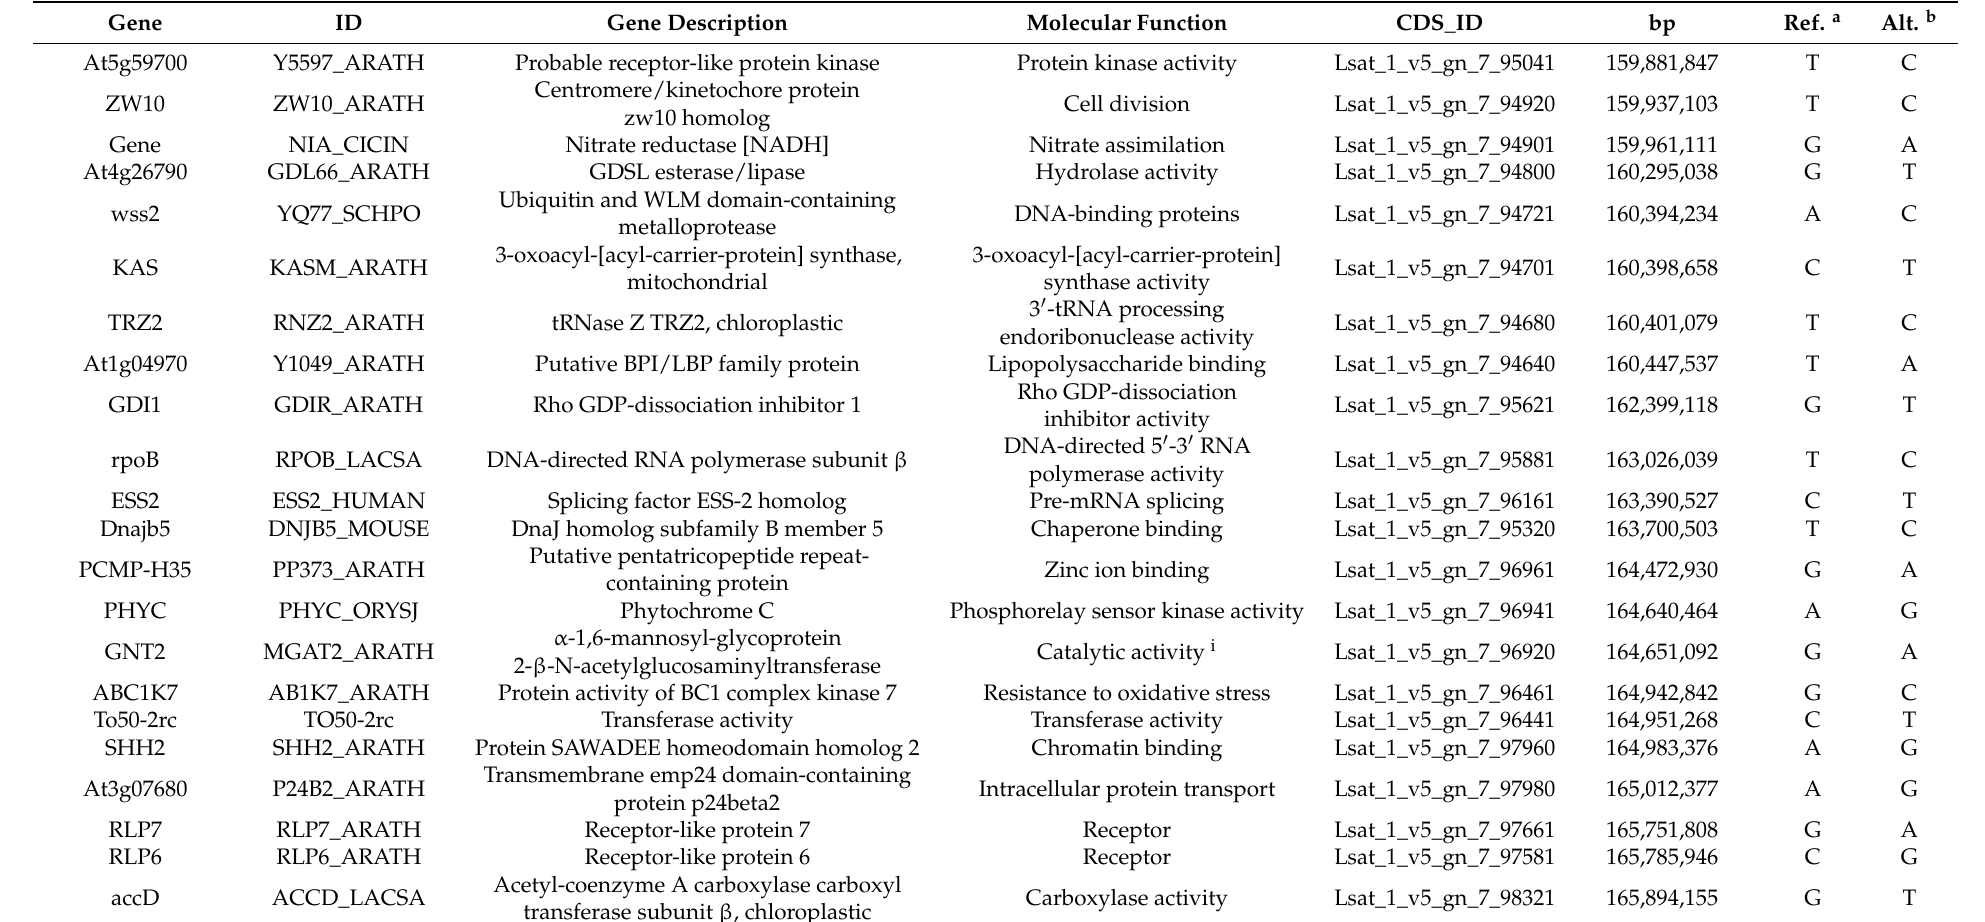
Table 5. List of SNPs identified in the QTL region on chromosome 7 and their annotated candidate